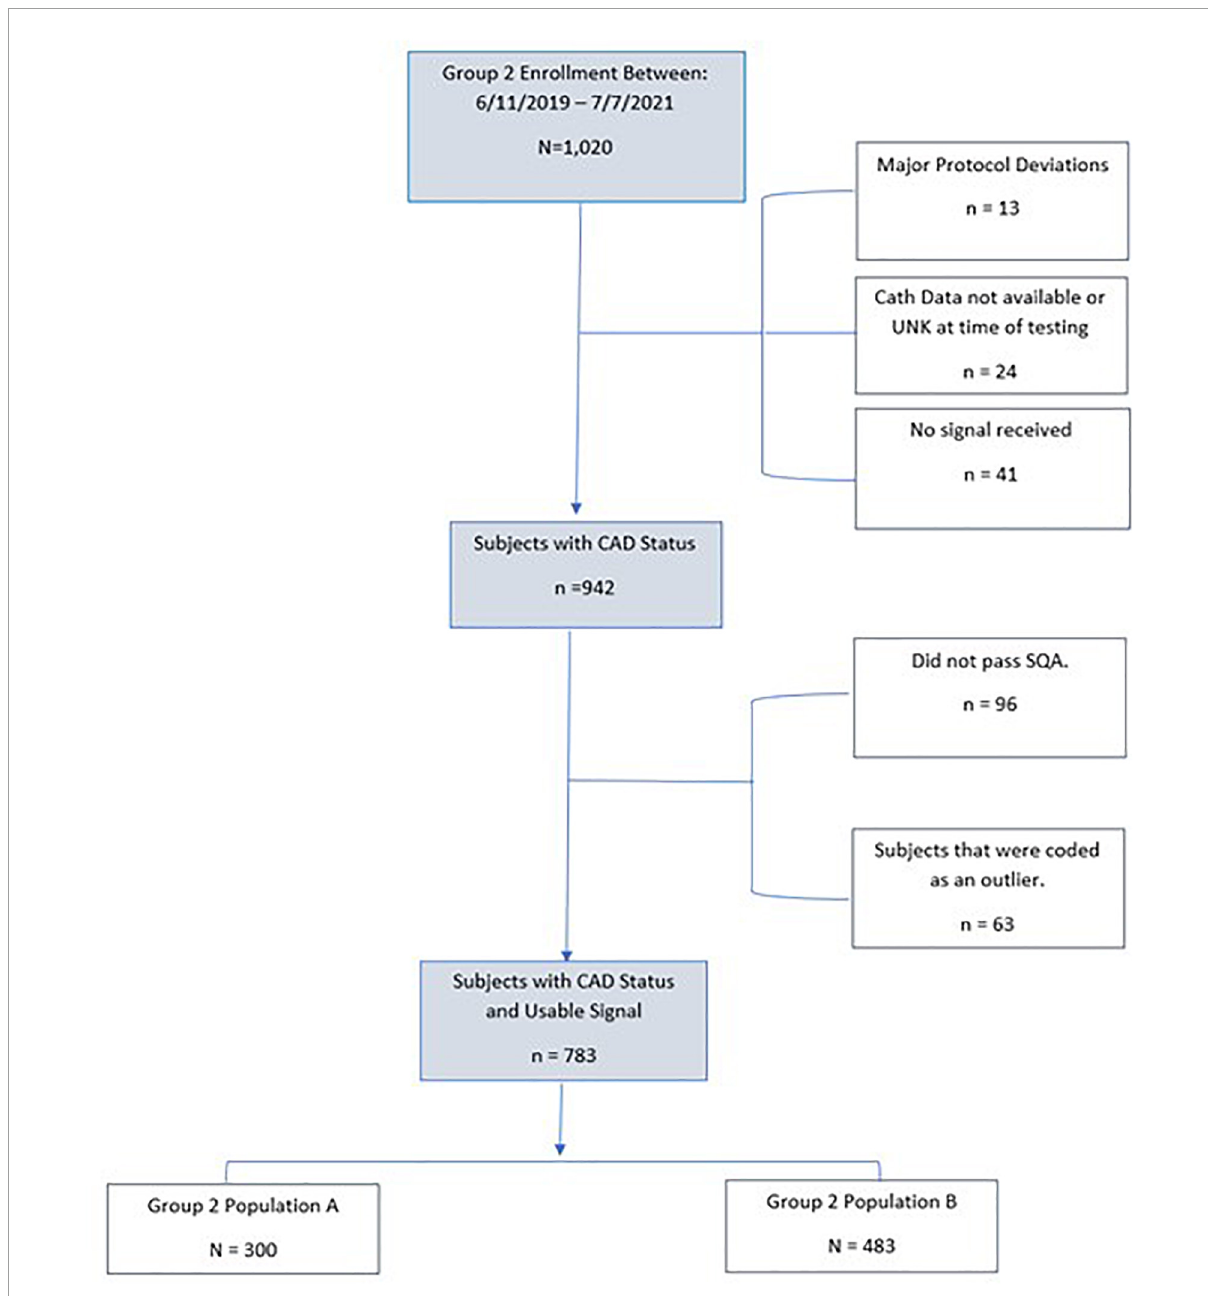
FIGURE5 Consort diagram of Group 2 (Population A and Population B) validation